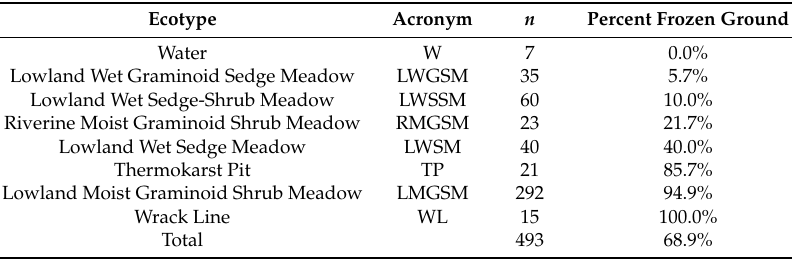
Table 1. Percent of sample sites with frozen ground by